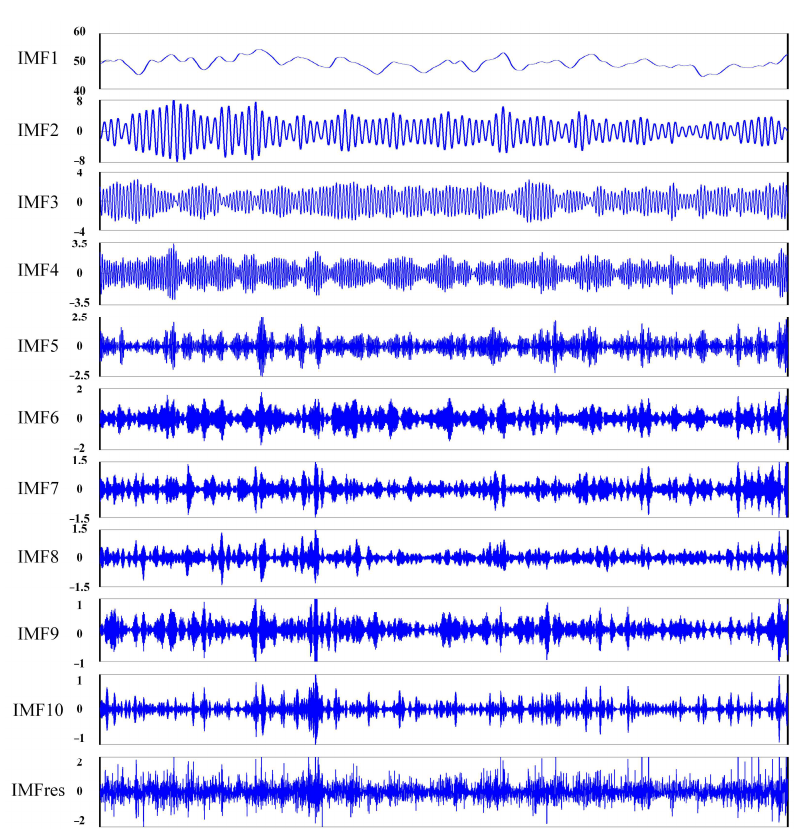
Figure 4. Decomposition results of the first variational modal decomposition.